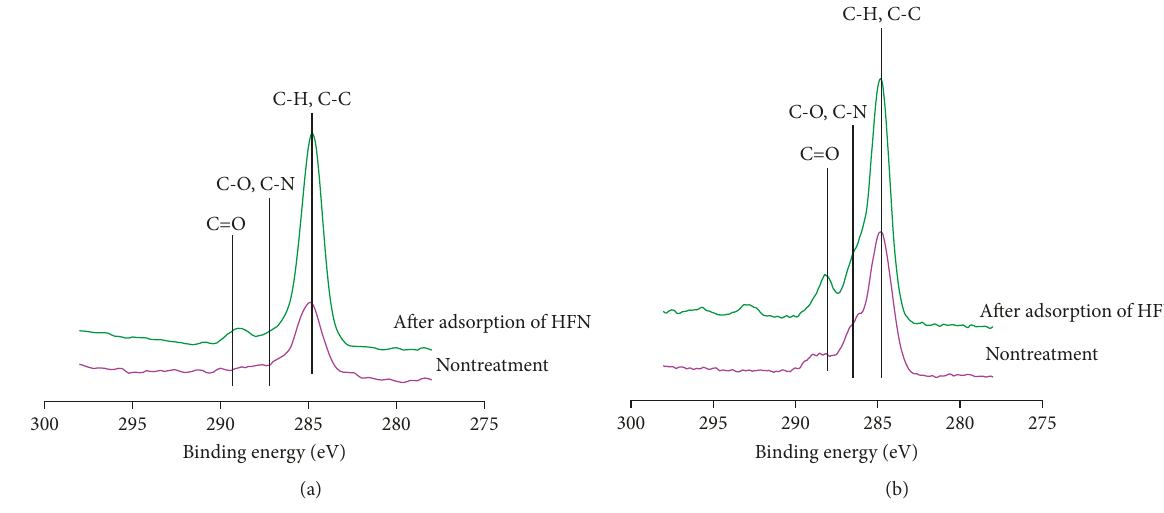
Figure 8: C1s XPS spectra of (a) Ti and (b) TNS QCM sensors after immersion in